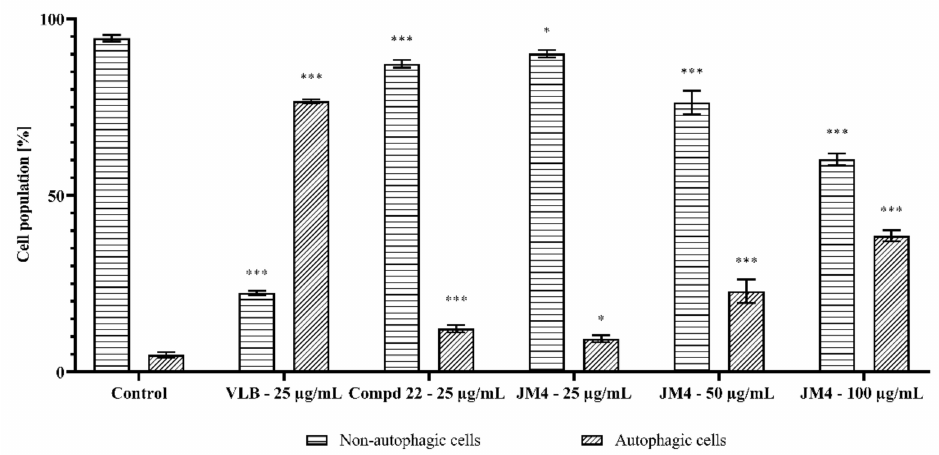
Figure 8. Percentage of nonautophagic and autophagic C32 melanoma cell population after 24 h incubation with JM4 (25, 50, 100 µ g/mL), 22 (25 µ g/mL) and vinblastine sulfate (VLB) (25 µ g/mL). Mean percentage values from three independent experiments ( n = 3) done in duplicate are presented. * p < 0.05 versus control group, *** p < 0.001 versus control